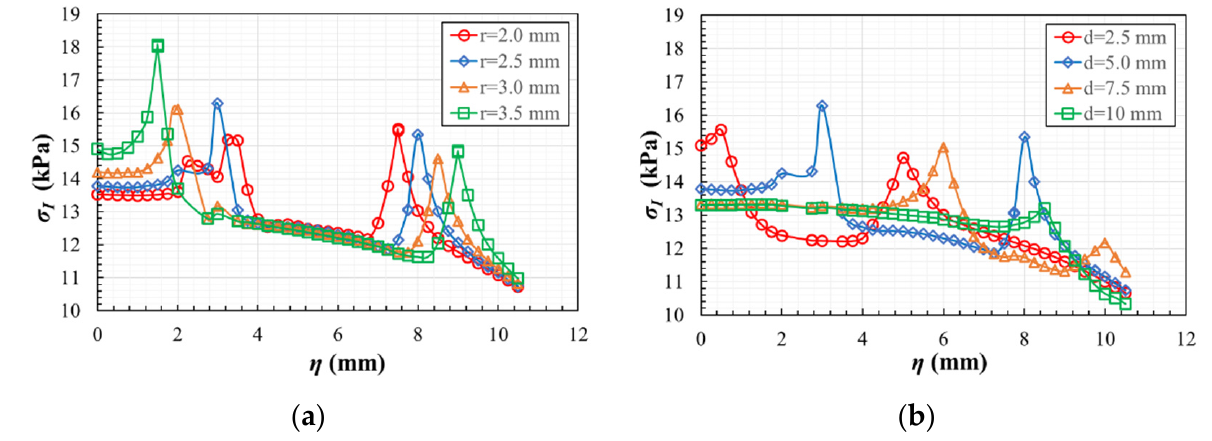
Figure 13. In geometry A for the CCC loading case: ( a ) influence of the opening radius for d = 5 mm; ( b ) influence of the centre position for r = 2.5 mm.